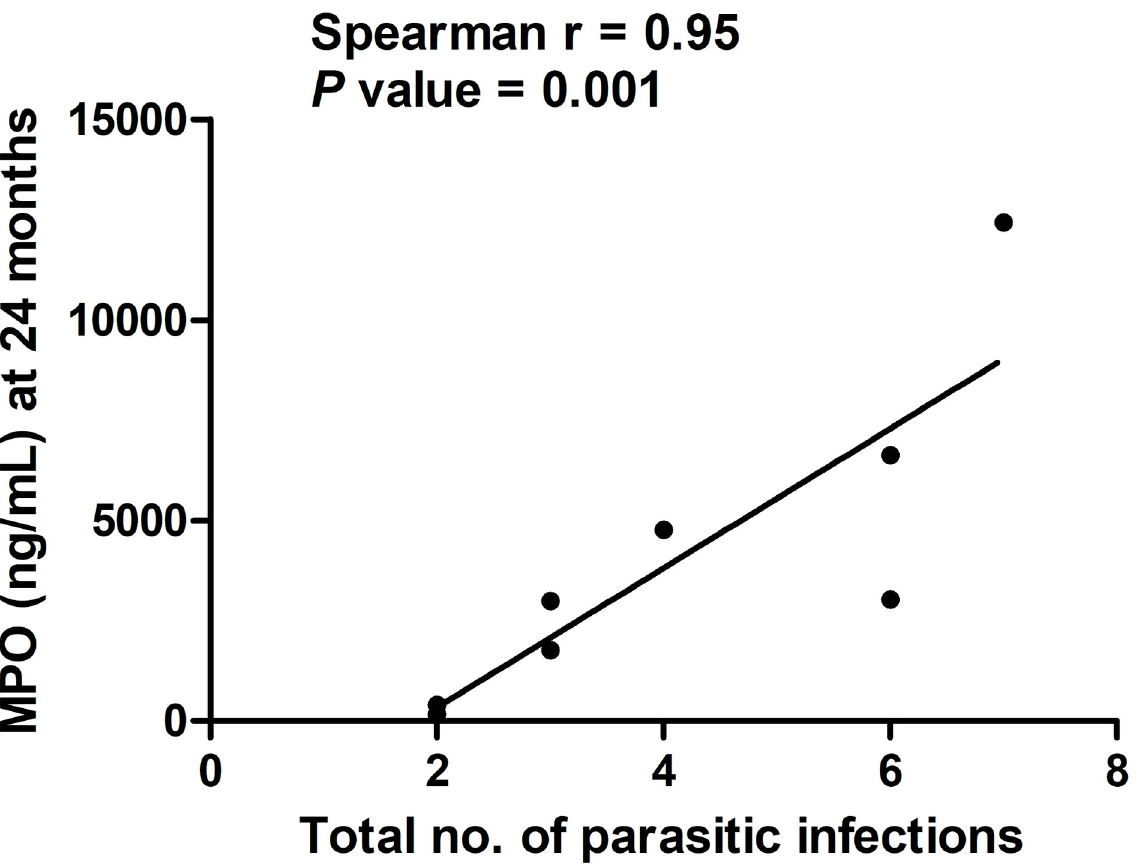
Fig 3. Correlation of the total number of parasitic infections (n = 8) with fecal MPO levels at 24 months. The X-axis indicates the total number of parasitic infections, while the Y-axis denotes fecal MPO levels (ng/mL) at 24 months of age. We performed the Spearman correlation test for statistical evaluation (r = 0.95 and P =